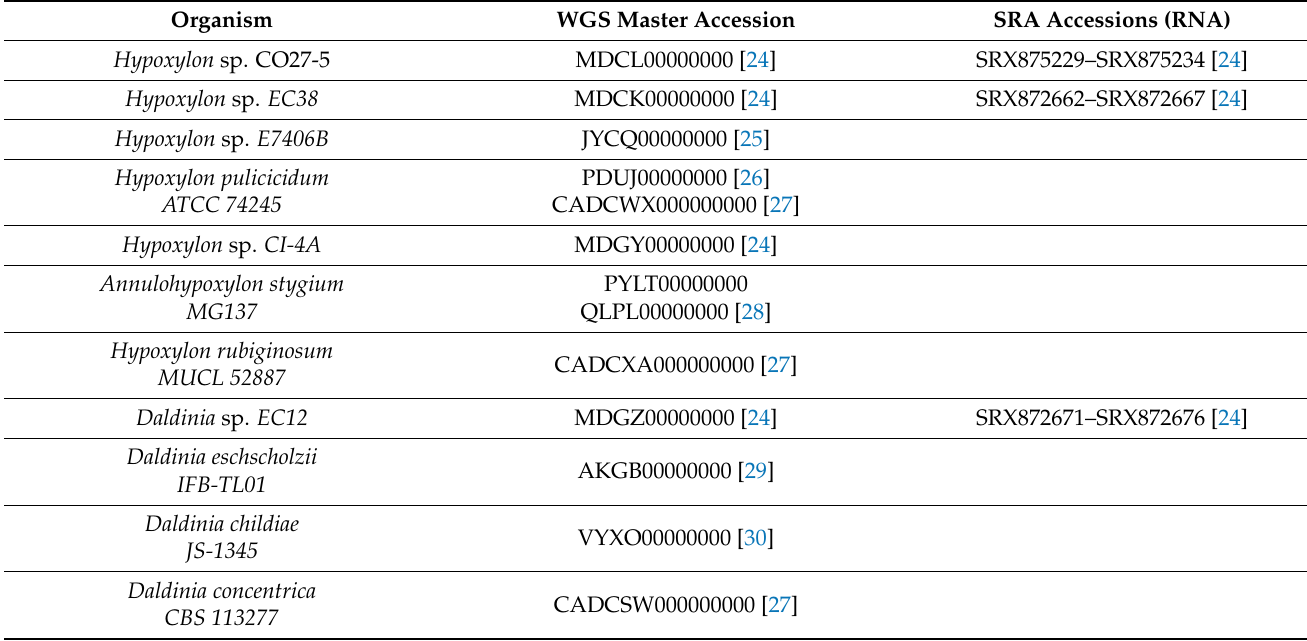
Table 1. Genome sequences containing sister (stw)introns and Sequence Read Archive (SRA) databases employed in this